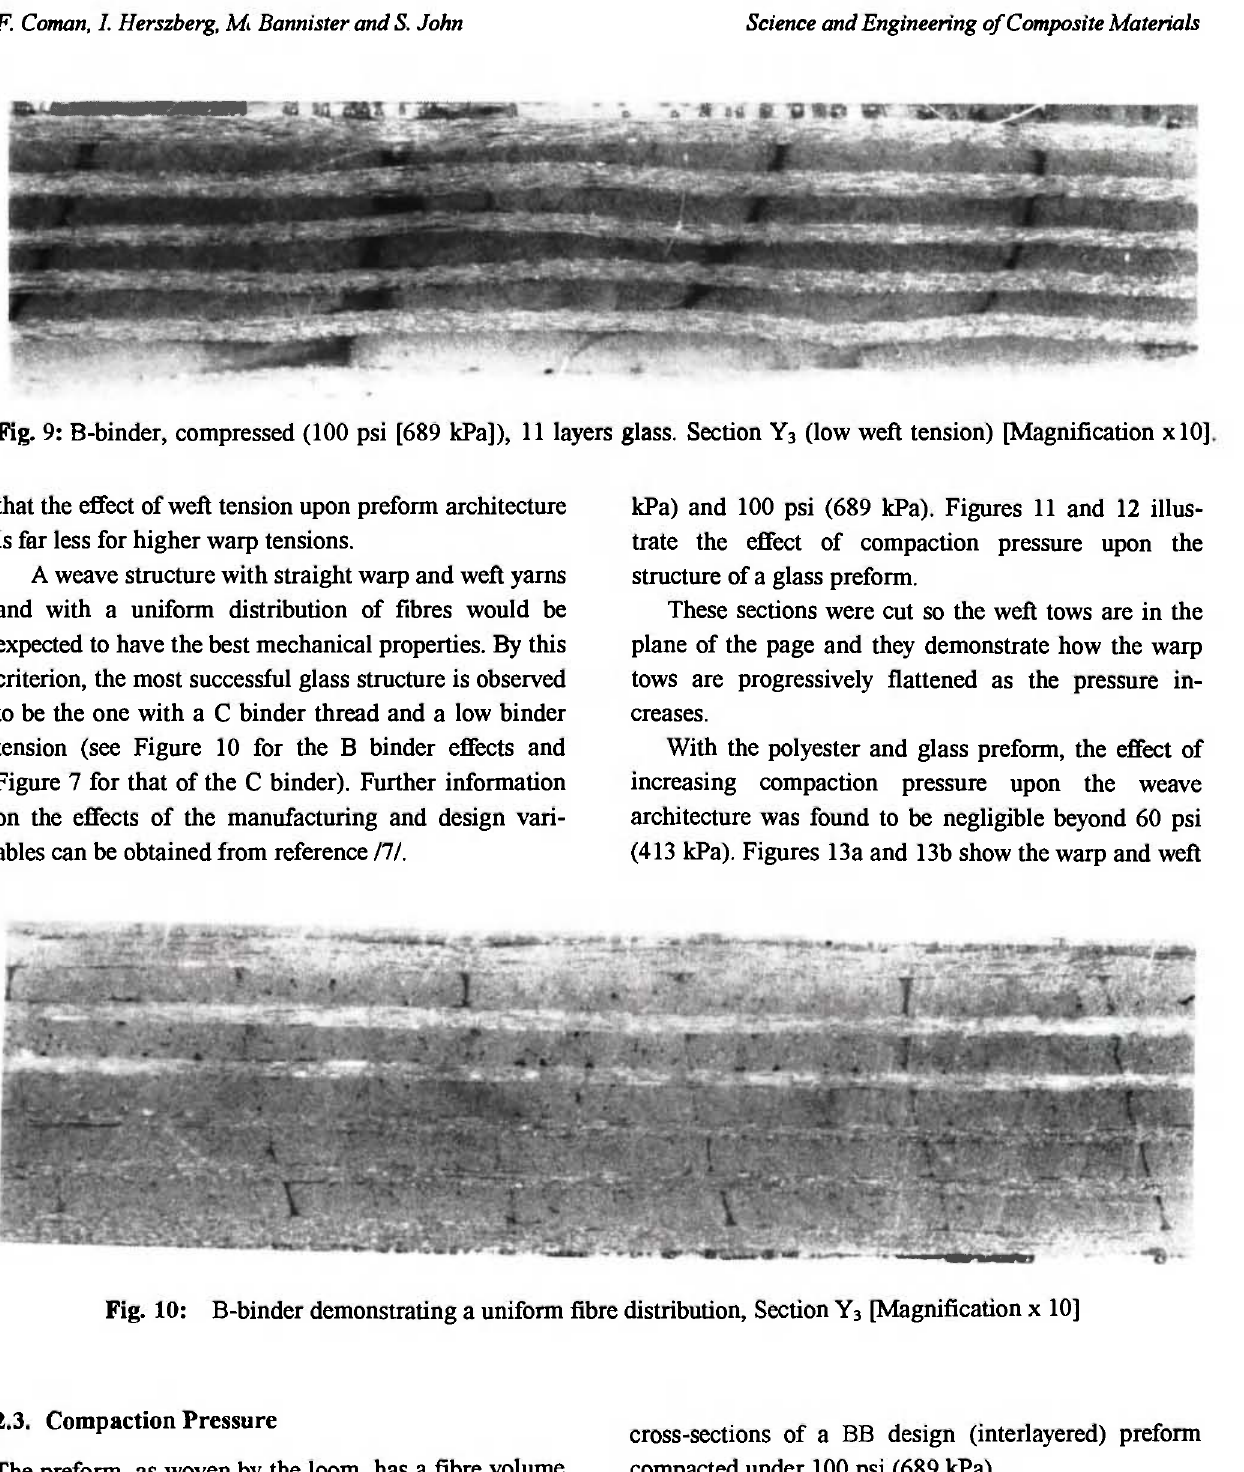
[Magnification χ 3